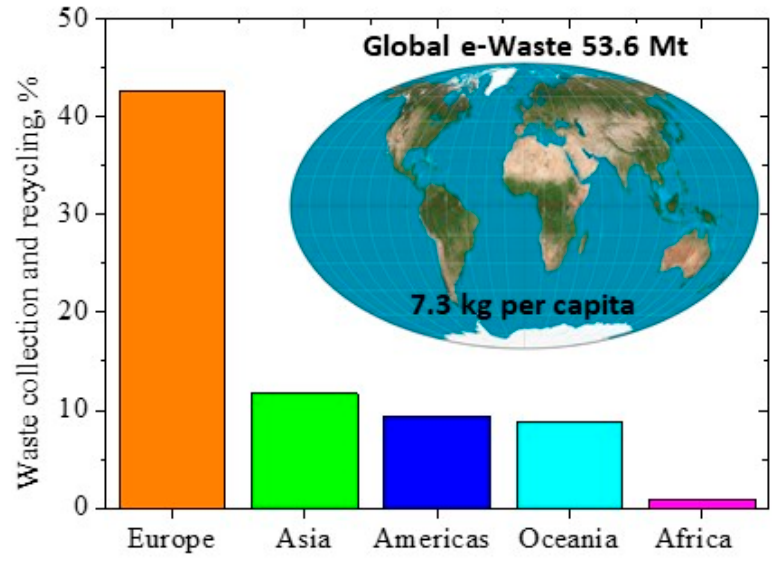
Figure 1. Global e ‐ waste collection and recycling rates. Figure was made by authors. Figure 1. Global e-waste collection and recycling rates. Figure was made by authors. Less than 40% of all e-waste in the EU is recycled. Recycling practices vary across the EU. In 2017, Croatia recycled 81% of all electronic and electrical waste, compared to 21% in Malta